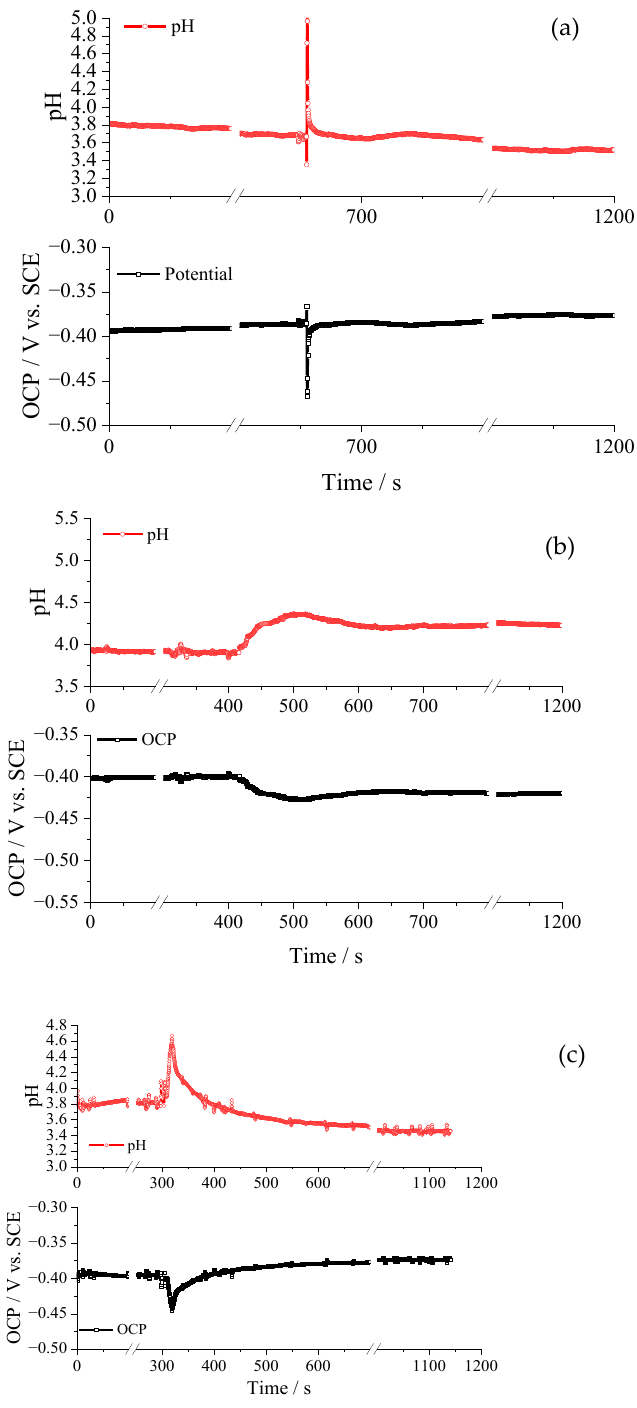
Figure 5. Plots of open circuit potentials and pH with respect to time for ( a ) electropolished Al, ( b ) AA 2024 alloy after NaOH etching and HNO 3 de-oxidation and ( c ) finely polished AZ91D alloys in the SurTec 650 ChromitAL solutions (40 °C).